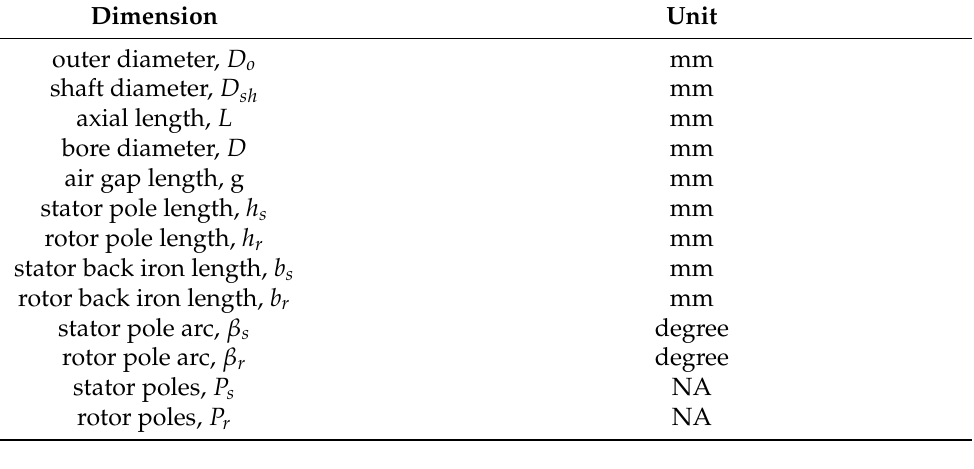
Table 1. SRM dimensions.